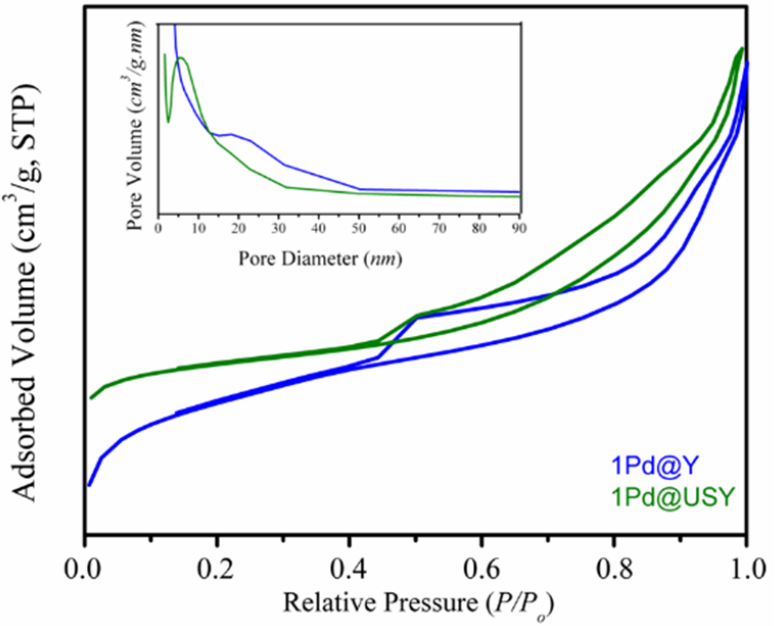
Figure 3. N 2 adsorption-desorption isotherms of the 1Pd@Y and 1Pd@USY samples. The pore size distribution is given in the inset. Table 1. Physico ‐ chemical characterization of the catalytic samples.